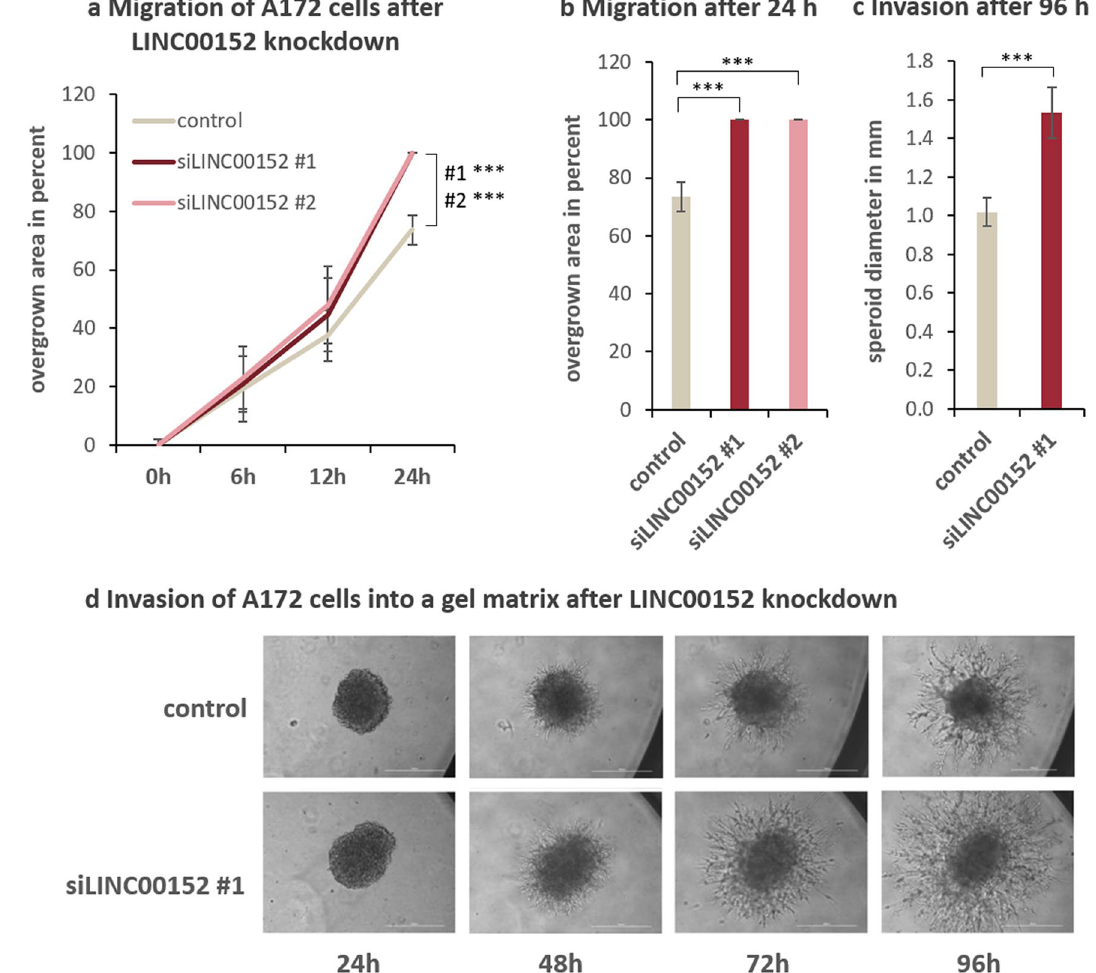
Figure 2. LINC00152 knockdown enhances migration and invasion of A172 GBM cells. ( a ) Migration of cells after LINC00152 knockdown through a cell-free gap of defined width was compared to cells transfected with